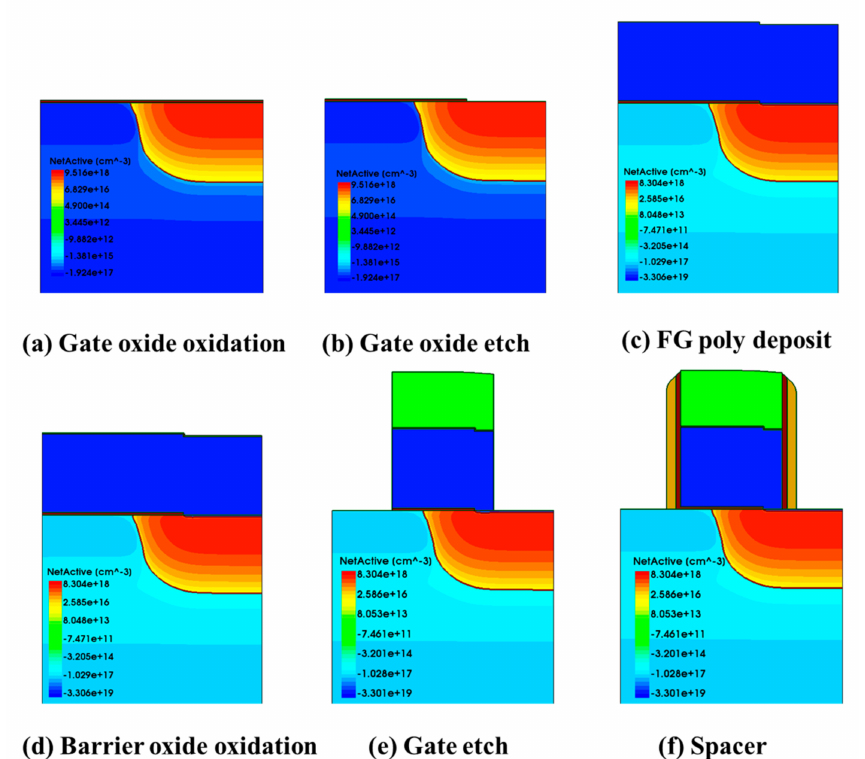
Figure 2. The main process simulation results ( a ) Gate oxide oxidation (8 nm). ( b ) Gate oxide etch to fabricate tunneling window. ( c ) FG poly deposit. ( d ) FG and CG barrier oxide oxidation (4 nm). ( e ) Gate etch. ( f ) Fabricate spacer of the